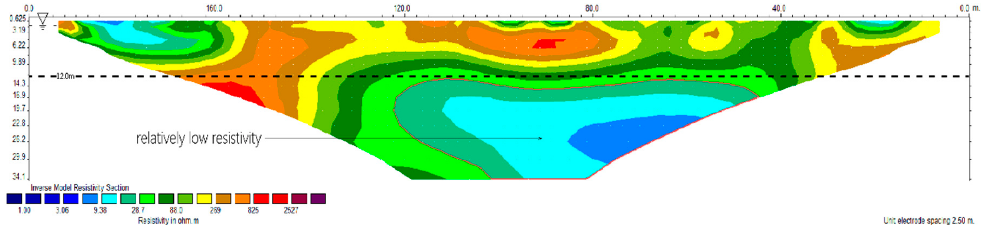
Figure 5. L2 measuring result diagram of the measuring line of the Wenner-Schlumberger Array.